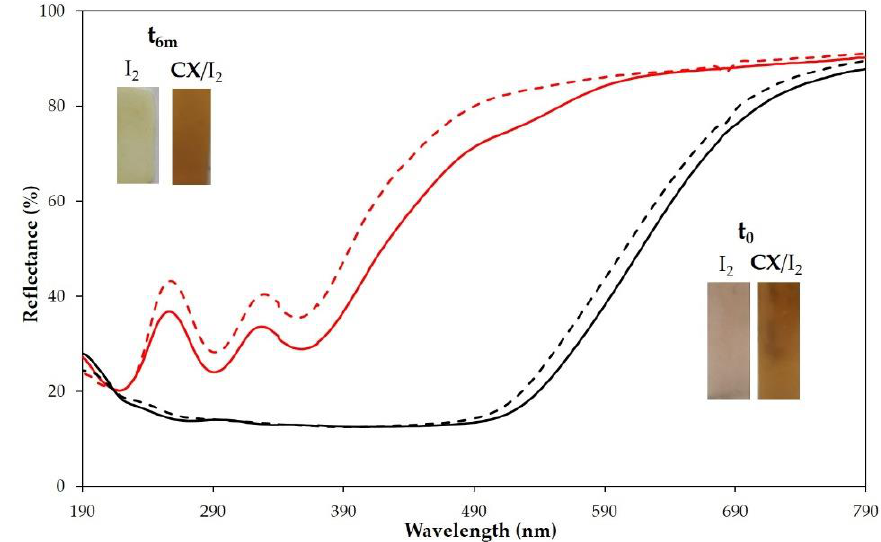
Figure 9. Reflectance (%) spectra of PP polymer films loaded with iodine (red lines) or CX/iodine complex in chloroform solution (black lines) at t 0 (full lines) and after 6 months (dashed lines). Insets: pictures of the samples at t 0 and after 6 months.